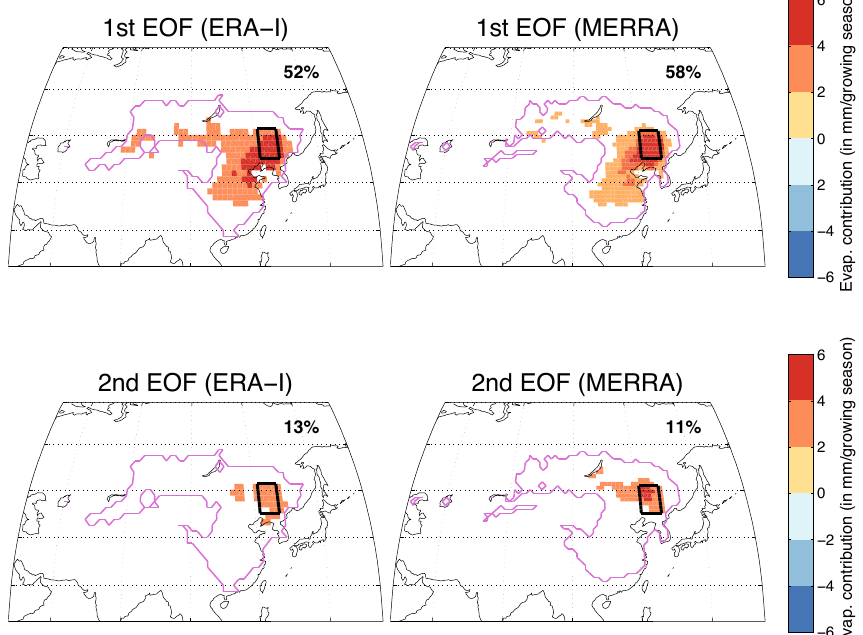
Figure 7. Comparison of first and second EOFs for northern China (ERA-Interim on left and MERRA on right), for the period 1980– 2011. The magenta line indicates the 5mmgrowingseason − 1 precipitationshed boundary, the black box indicates the sink region, and the bold number in the upper right corner indicates the amount of variance explained by the associated pattern. We do not show values < 2 mm growing season − 1 , for the sake of clarity in the figure.